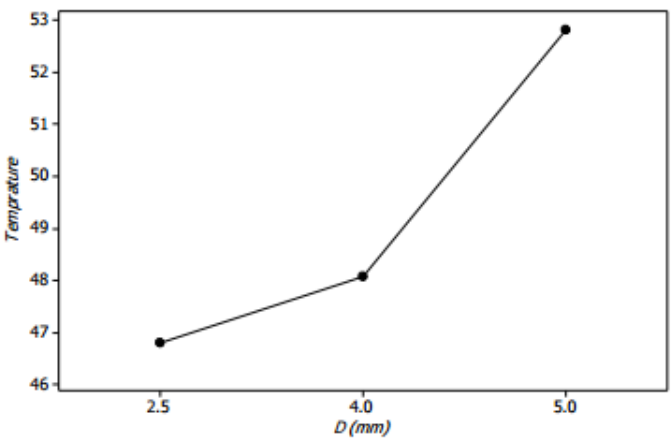
Figure 2: Effect if varying drill bit diameter on temperature.